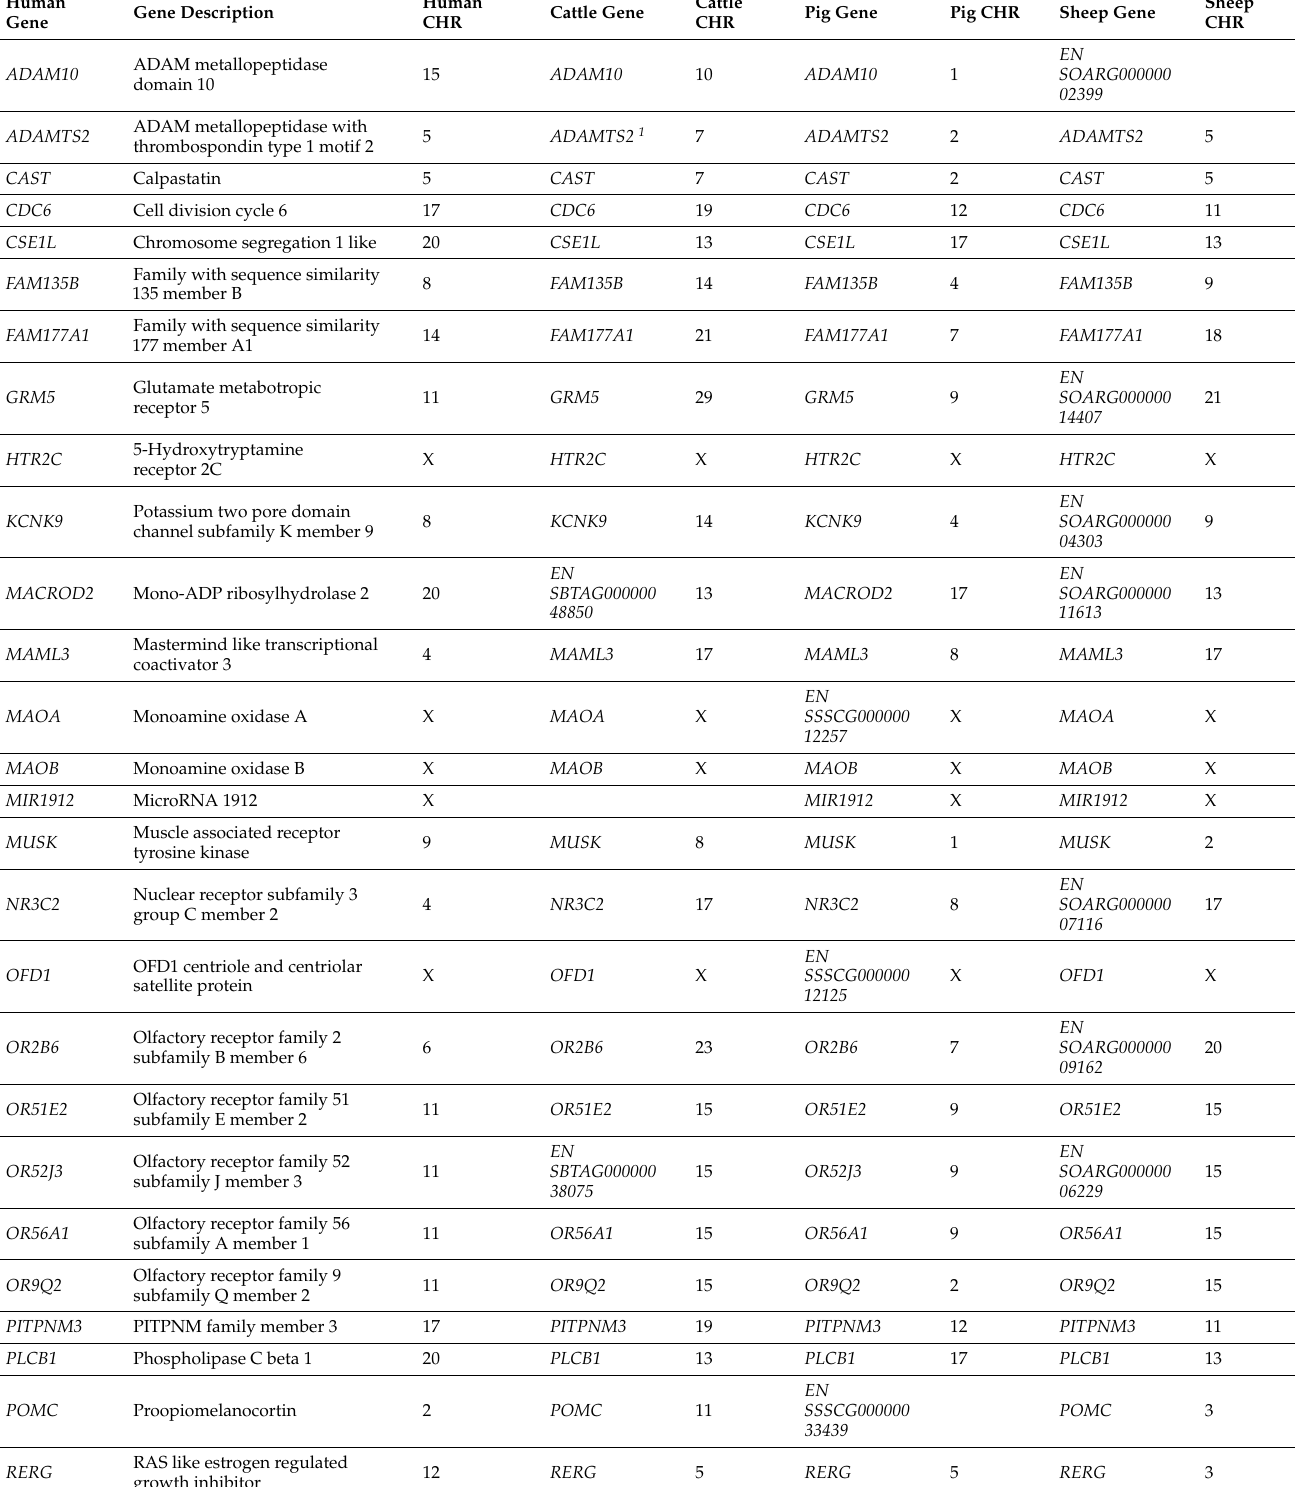
Table 5. Selected candidate genes with their respective identification in the four species (i.e., cattle, human, pigs, and sheep) and chromosome (CHR) location. The selection of genes to present in this table depended on the recurrence of those genes within and across species as well as being reported in literature as biologically relevant genes affecting behavior. Cattle Sheep CHR Pig Gene Pig CHR Sheep Gene